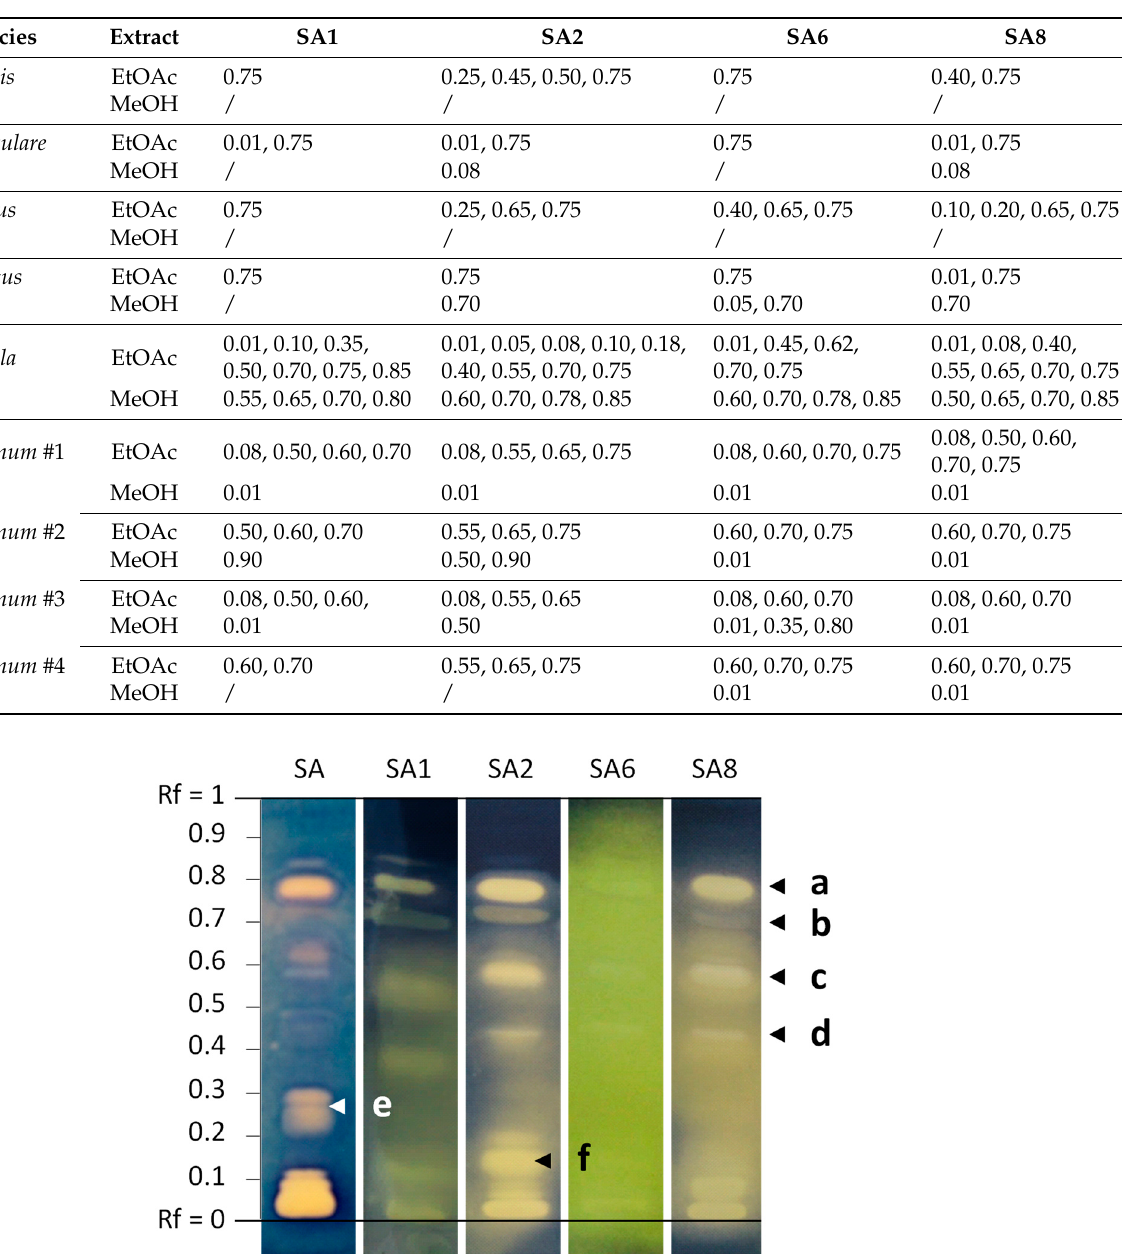
Table 3. Rf values of inhibition bands induced by mushrooms extracts on bioautograms against the four MDR S. aureus strains SA1, SA2, SA6, and SA8.